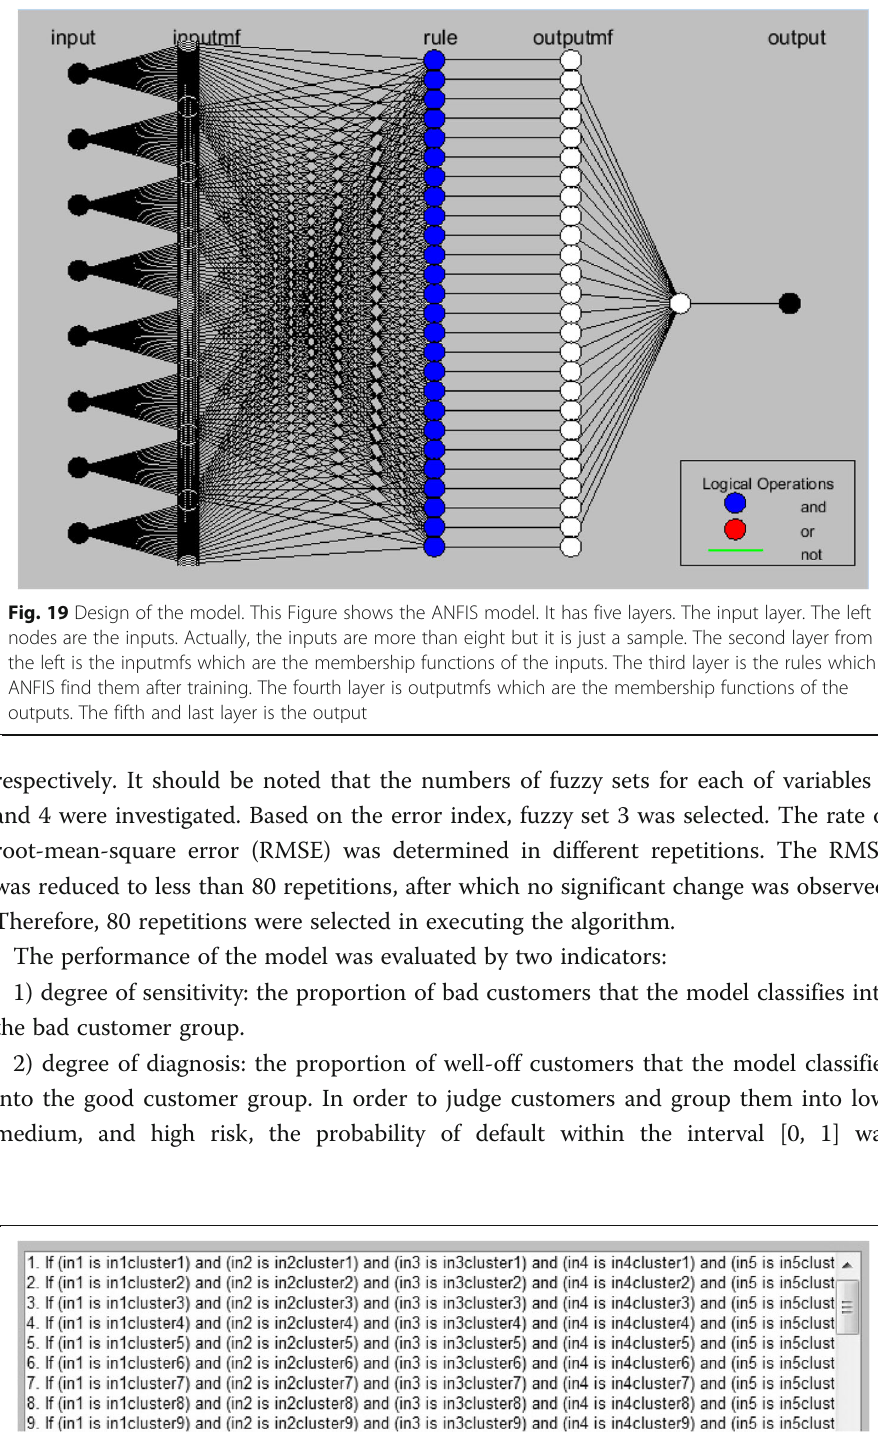
Fig. 20 The fuzzy Inference system of the network. Customer information was processed in Matlab R2015b before entering the model. Next, the 9000 records were entered into the model. Given that the range of the values each variable can take is different, we normalized all data by converting them into numbers between zero and one. After this stage, the training and testing data are separately entered into the software and begin to fit the model. This Fig shows the Fuzzy Inference system that is obtained in process of training the network in Matlab